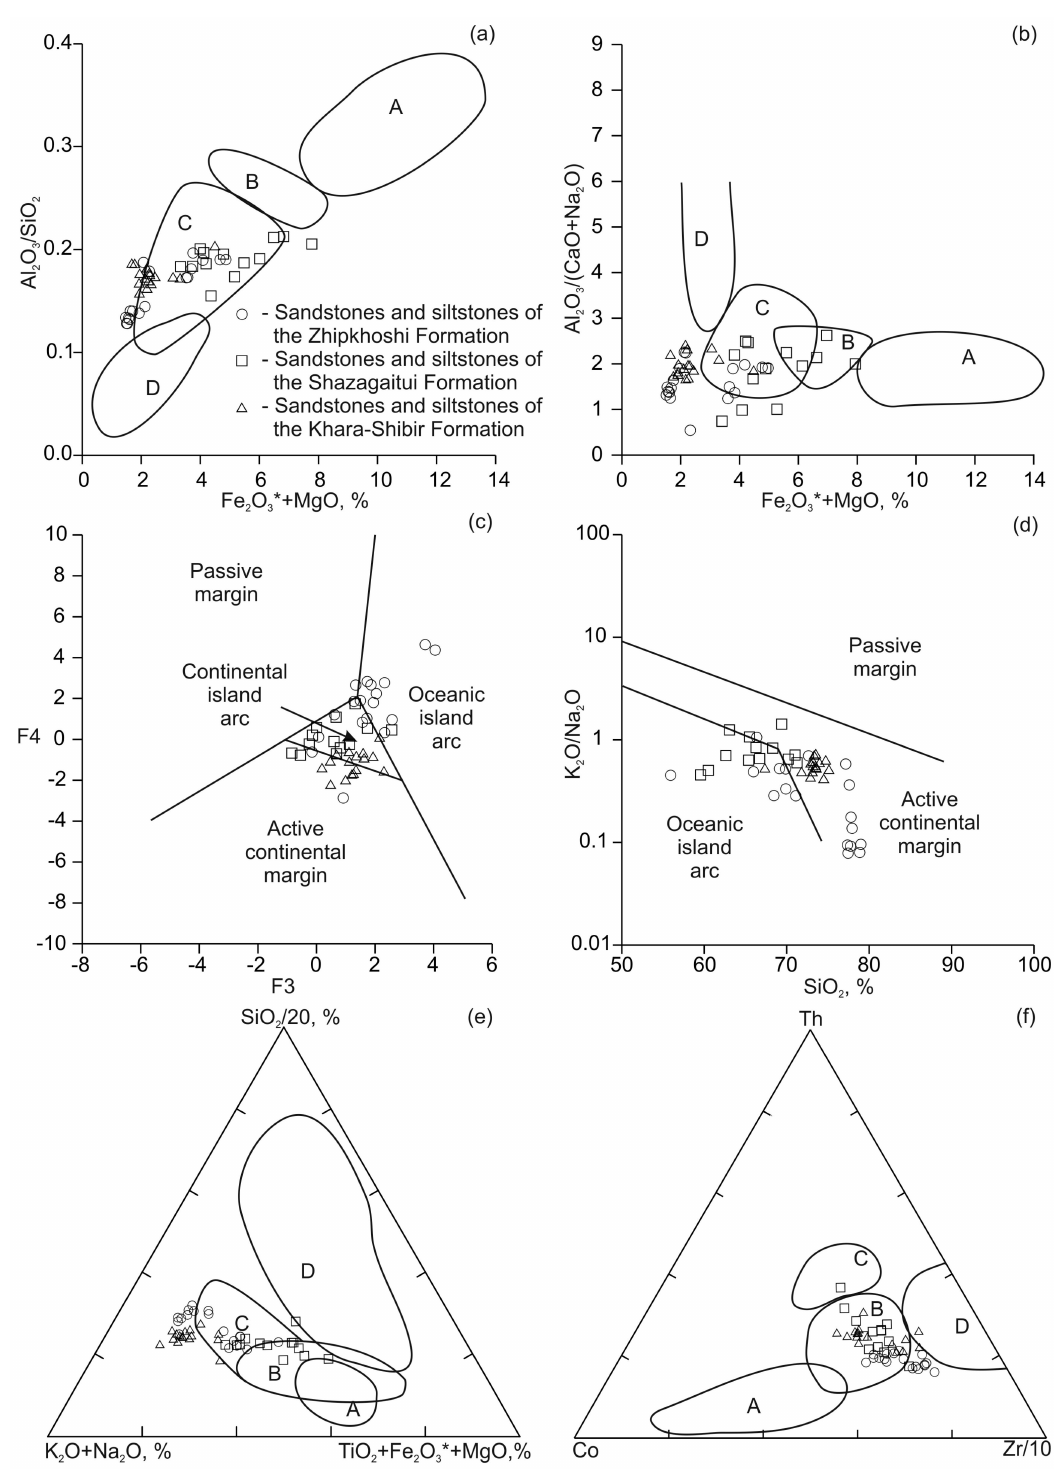
Figure 11. Tectonic discrimination plots of Fe 2 O 3 * + MgO versus Al 2 O 3 / SiO 2 after [108] ( a ), Fe 2 O 3 * + MgO versus Al 2 O 3 / (CaO + Na 2 O) after [108] ( b ), F3 versus F4 after [109] ( c ), SiO 2 versus K 2 O / Na 2 O after [109] ( d ), (K 2 O + Na 2 O)–(TiO 2 + Fe 2 O 3 + MgO)–(SiO 2 / 20) after [111] ( e ), and Co–Zr / 10–Th after [112] ( f ) for siliciclastic rocks of the Chiron Basin. Fields for the various tectonic settings: A—Oceanic island arc; B—Continental island arc; C—Active continental margin; D—Passive